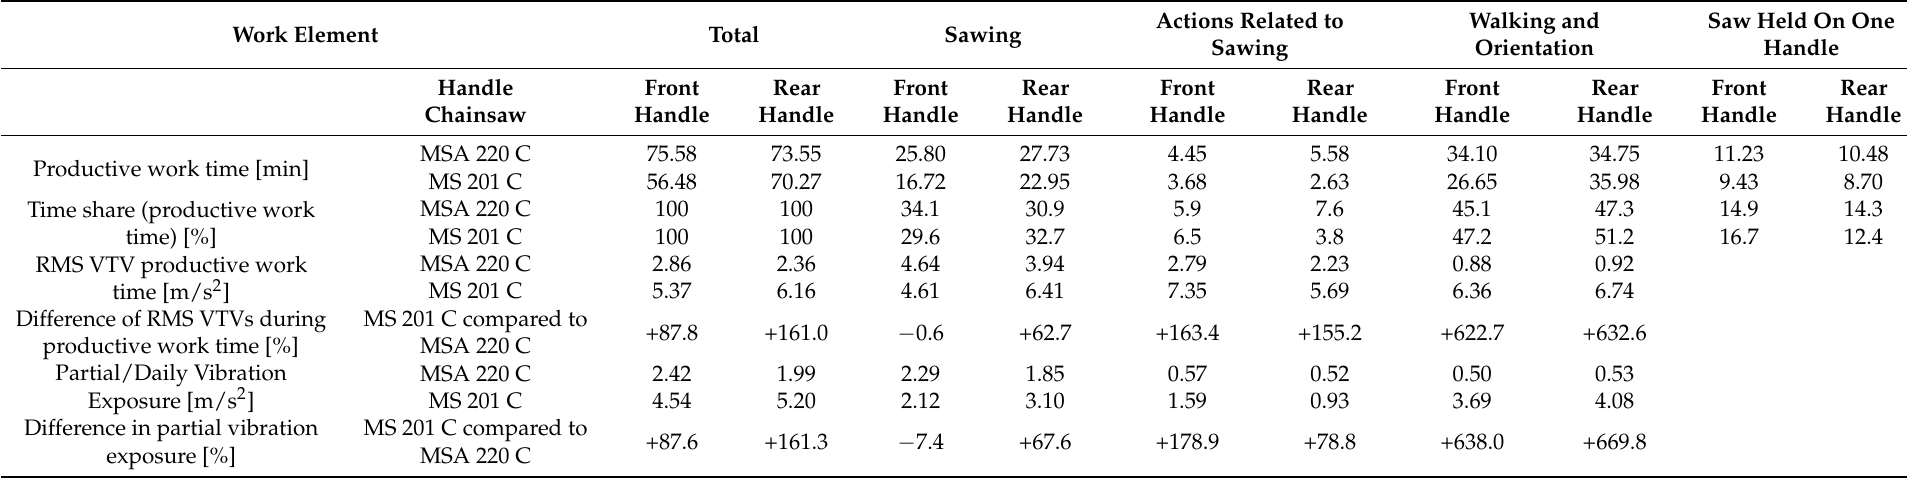
Table 3. Exposure time and RMS VTVs as well as the resulting partial vibration exposure for the different work elements divided by type of chainsaw and sensor position. Work Element Total Sawing